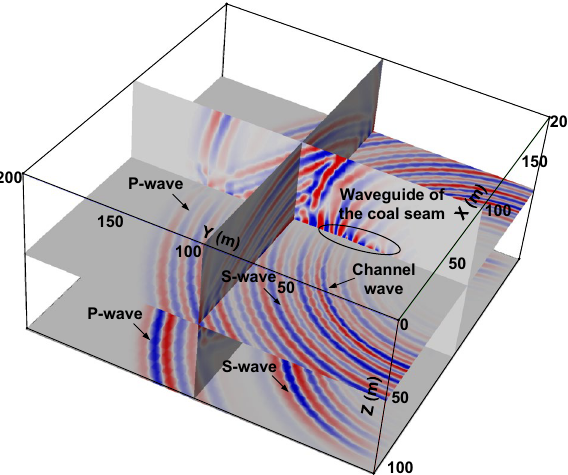
Fig. 5 Combined snapshots of the 3D working face model (Source No. 11 at T = 50 ms)